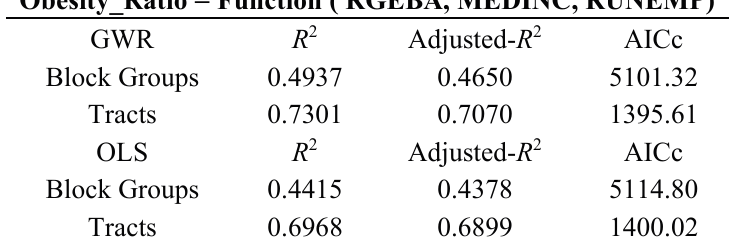
Table 2. Summary output from geographically weighted regression (GWR) and ordinary least squares regression